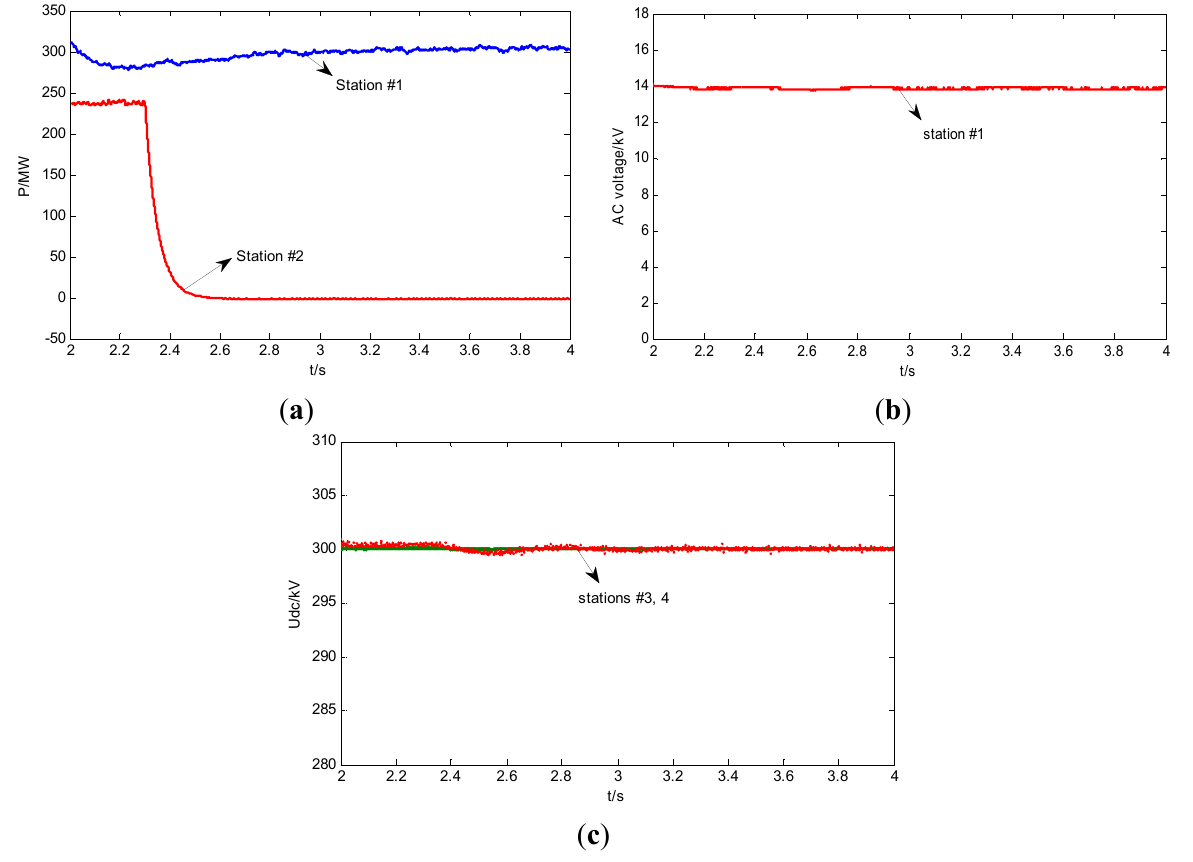
Figure 13. Dynamic response of rectifier outage ( a ) Active power of station # 1 and 2; ( b ) DC side voltage of station # 3 and 4; ( c ) AC side voltage of station #